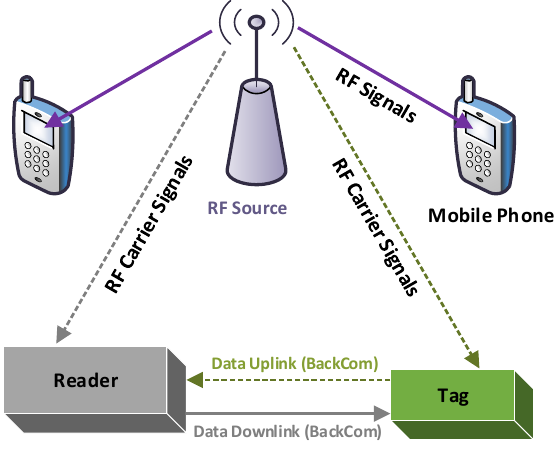
Figure 8. Ambient